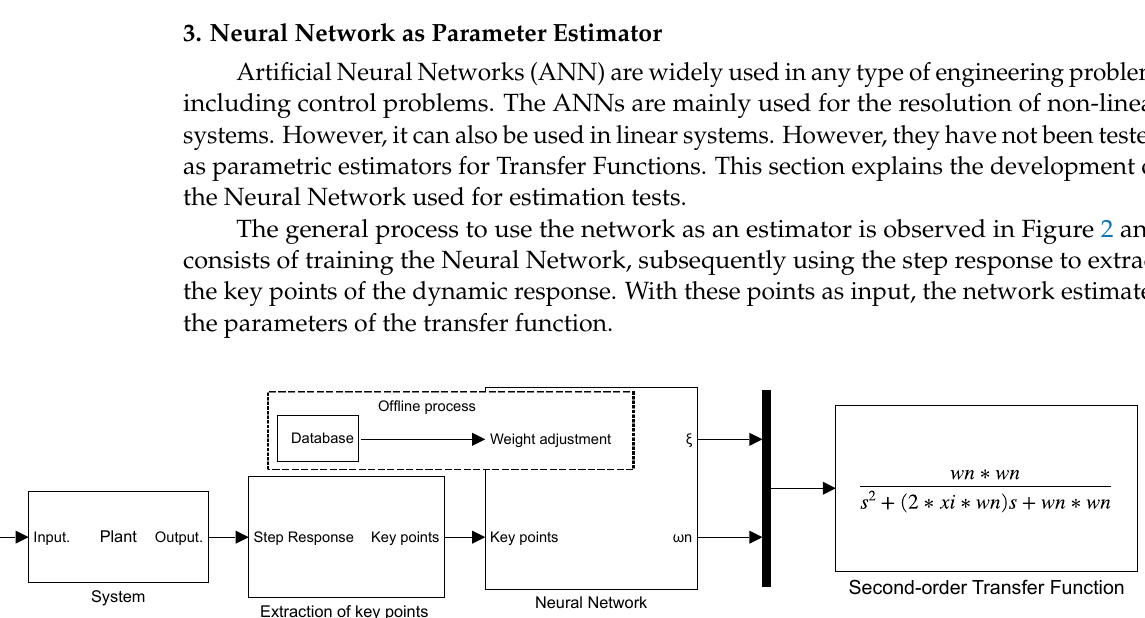
Figure 1. Key characteristics of the dynamic response to step input.